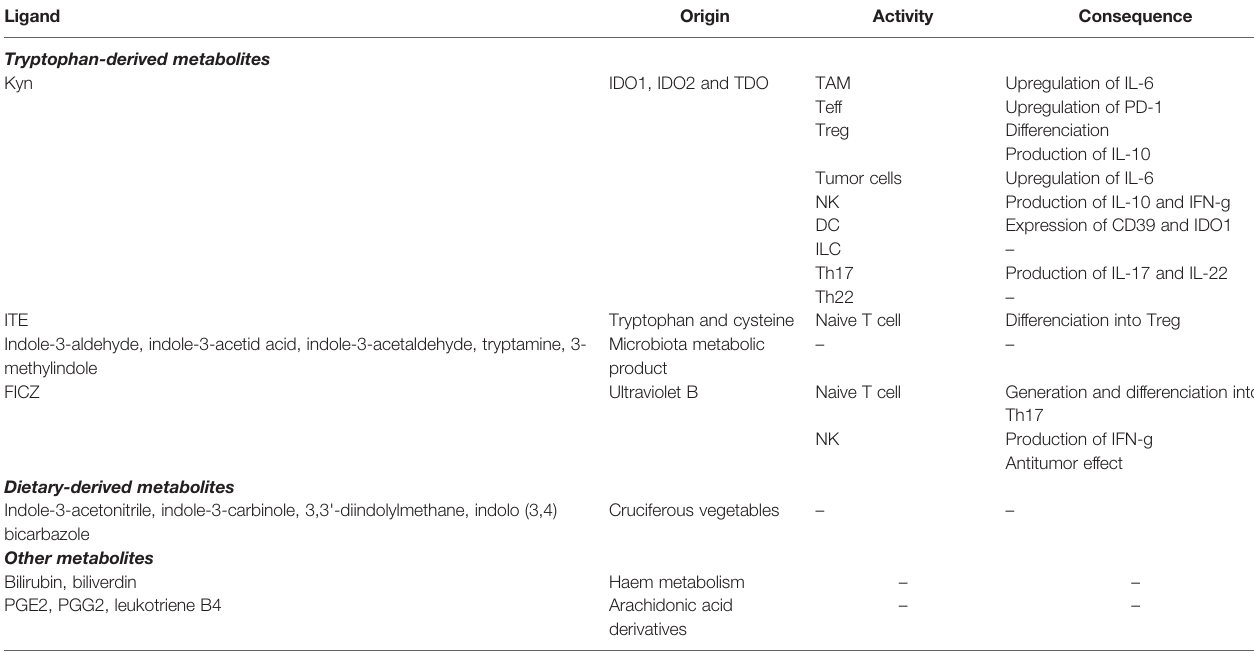
TABLE 1 | Endogenous AhR ligands, pathways and immune